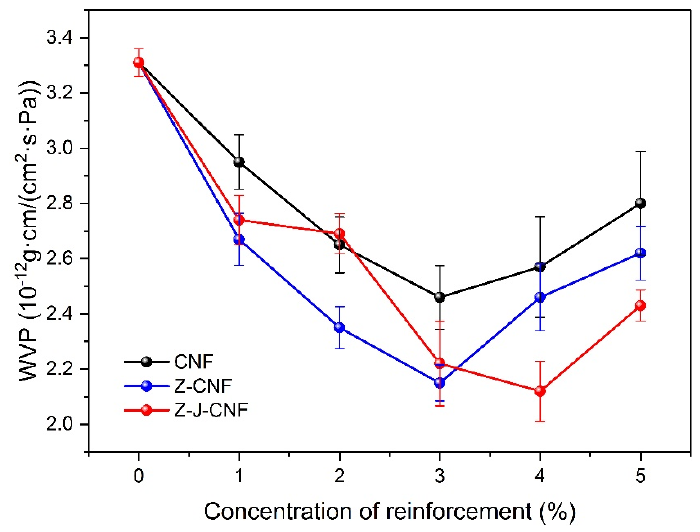
Figure 9. E ff ects of CNF, Z-CNF, and Z-J-CNF content on the water vapor permeability (WVP) of Figure 9. Effects of CNF, Z-CNF, and Z-J-CNF content on the water vapor permeability(WVP) of the the films.